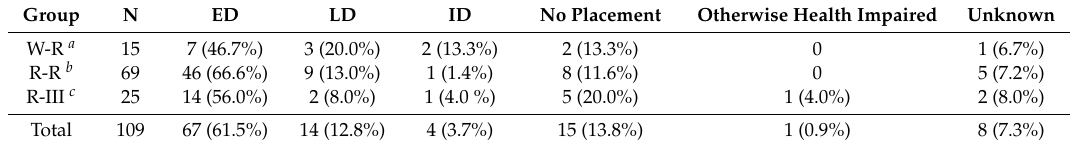
Table 4. Recommended special education diagnosis upon second test for all 3 testing